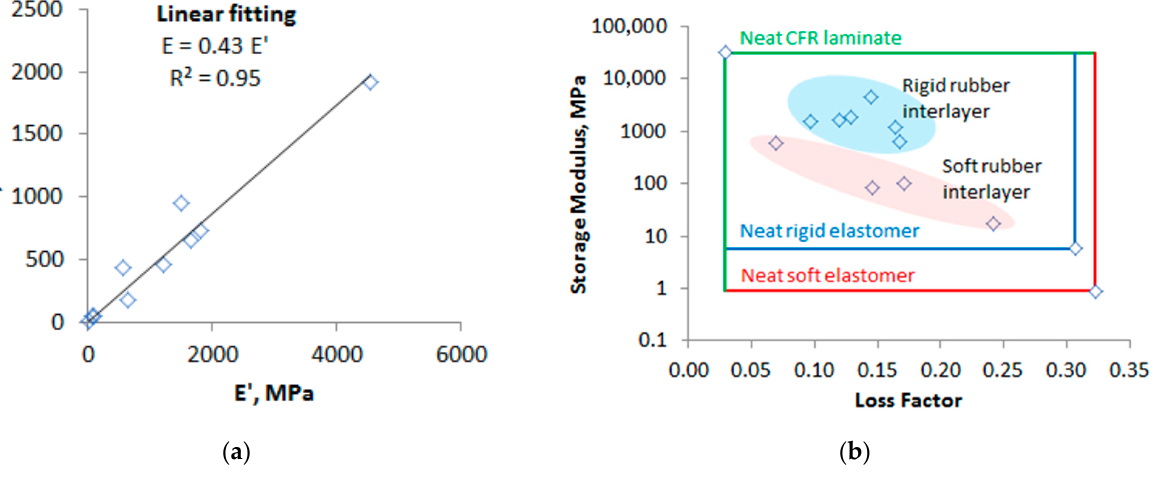
Figure 6. Correlation of the storage elastic modulus E’ with the quasi-static modulus E ( a ), and the loss factor tg δ ( b ). loss factor tg δ ( b